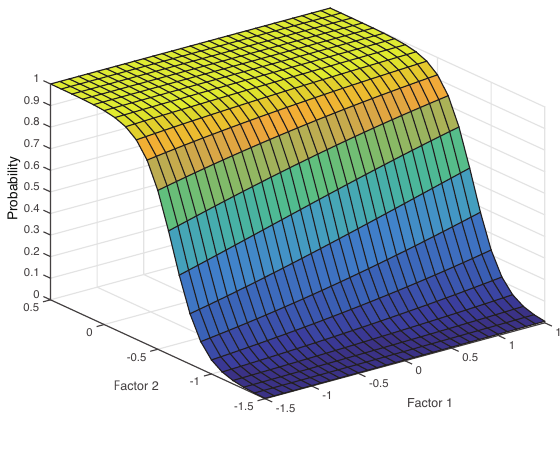
Figure 5. Probability distribution for b100 Model parameter estimation. Table 6 shows the possibility of discriminating between AD patients and control group subjects using a logistic regression function.